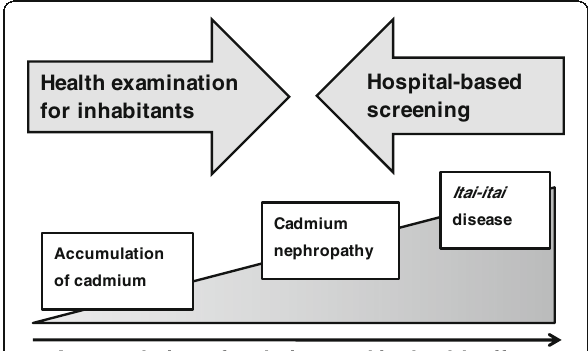
Fig. 3 Schematic diagram of a health examination for inhabitants and hospital-based screening in cadmium-polluted areas to detect patients with cadmium nephropathy or itai - itai disease in relation to cadmium exposure levels and its health